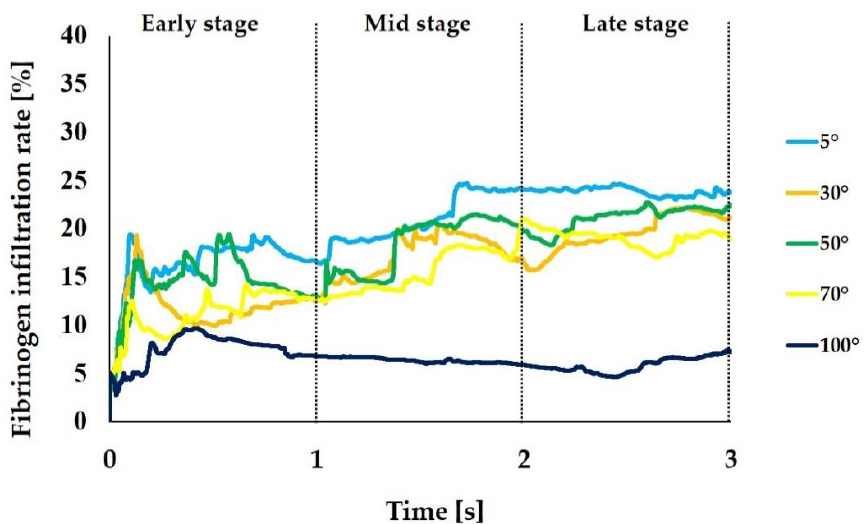
Figure 4. Fibrinogen infiltration rate (%) varying with different levels of hydrophilicity or hydrophobicity of the implant surfaces. The mass of fibrinogen located in the interfacial zone relative to the one in the entire area of the surrounding is expressed in %.